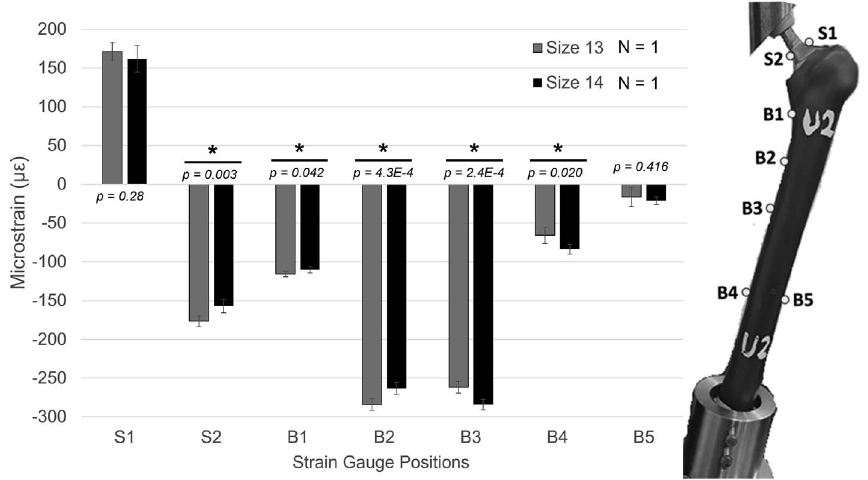
Figure 3. Summary of the strain measurements taken from strain gauges on different locations of the construct under a 500 N axial load. Uncemented size 13 and size 14 hip stems compared. *Highlights the statistical difference between corresponding groups ( P < 0.05).